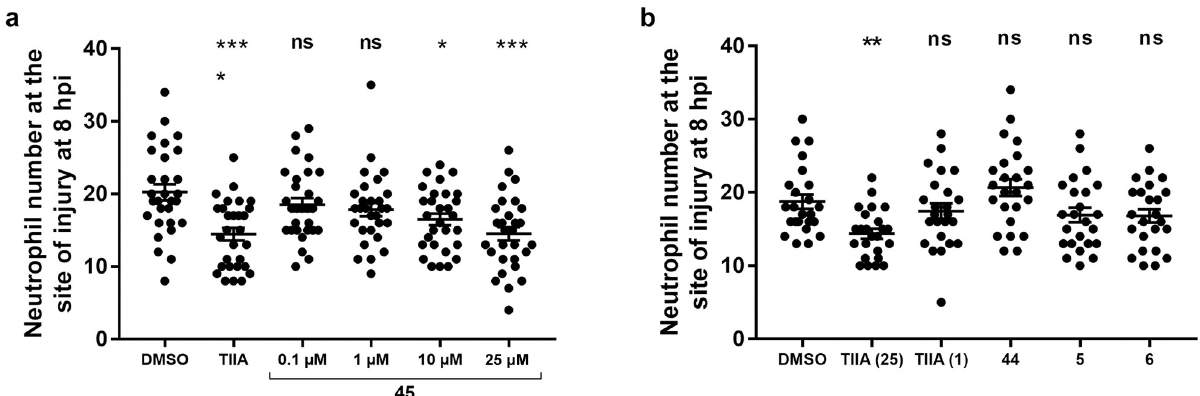
Fig 10. Effects of a) norlapachol 45 and b) lapachol 44, β -lapachone 5 and nor- β -lapachone 6 on resolution of neutrophilic inflammation. Tailfin transection was performed on transgenic zebrafish larvae, TgBAC(mpx : GFP)i114 (3 dpf), and at 4 hpi, good responders were subjected to compound treatments: DMSO (0.5%), TIIA 2 (25 μ M; also 1 μ M for b only, as indicated in brackets), norlapachol 45 ( a ; 0.1, 1, 10, 25 μ M as indicated) and lapachol 44 , β -lapachone 5 and nor- β -lapachone 6 ( b ; 1 μ M). Neutrophil number at the site of injury was assessed at 8 hpi by counting GFP+ cells. Data shown as mean ± SEM; n = 24–29 larvae from 3–4 independent experiments per graph. � P < 0.05, �� P < 0.01, ��� P < 0.001, ���� P < 0.0001, ns not significant, in comparison to the DMSO control (one-way ANOVA with Dunnett’s multiple comparison post-test).